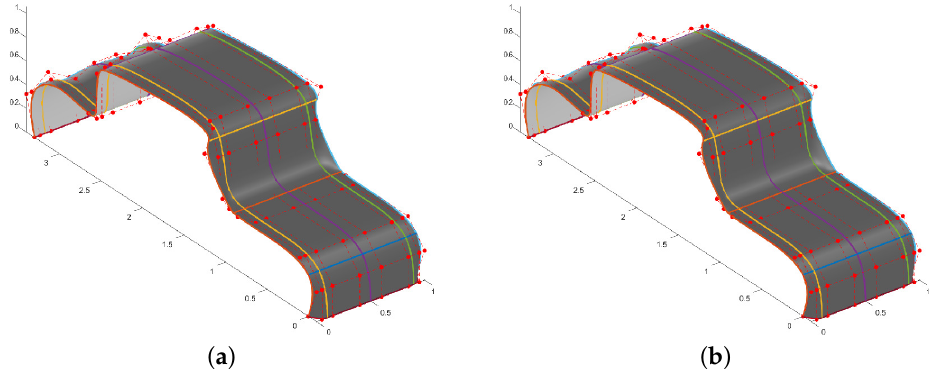
Figure 7. ( a ) Tensor product and ( b ) triangulated surfaces with R = 3, S = 6, m = 5, n = 11, 0,0,0,1 5,6,6,6 , V = 0,0,0,1 11,12,12,12 , being the barriers at knots U = { ÷ } { ÷ } u 2 , u 4 , v 2 , v 4 , v 6 , v 8 , v 10 . The network control points are taken from Test 1 of